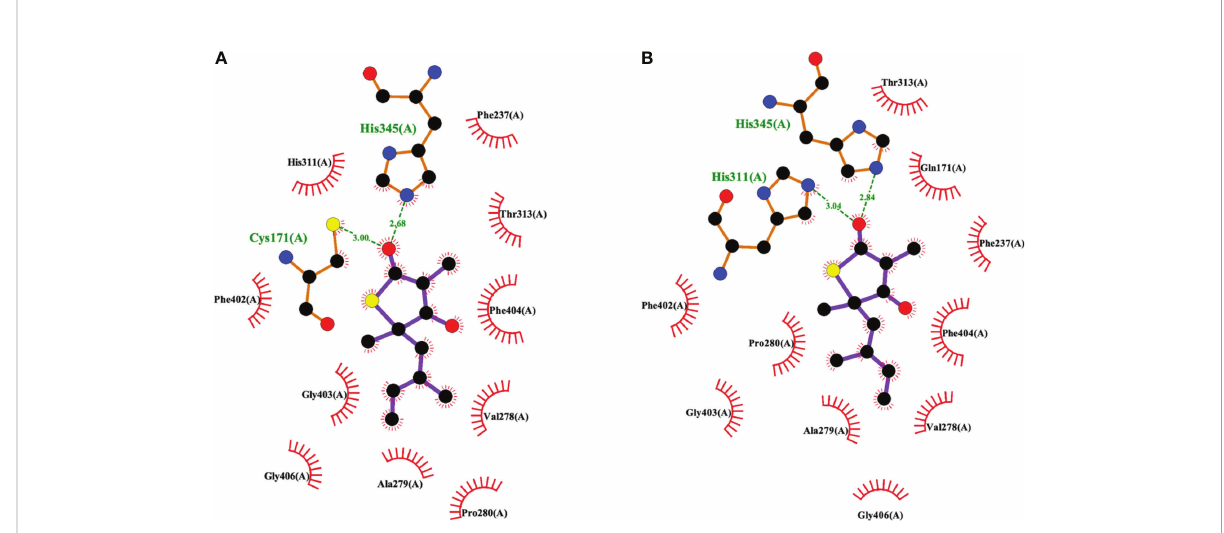
FIGURE 6 Interaction pro fi les for TLM bound to (A) wild type KasA (PDB ID 2WGE) and (B) KasA-C171Q (PDB ID 2WGG). Hydrogen bonds are shown as green dashed lines and distances are measured in